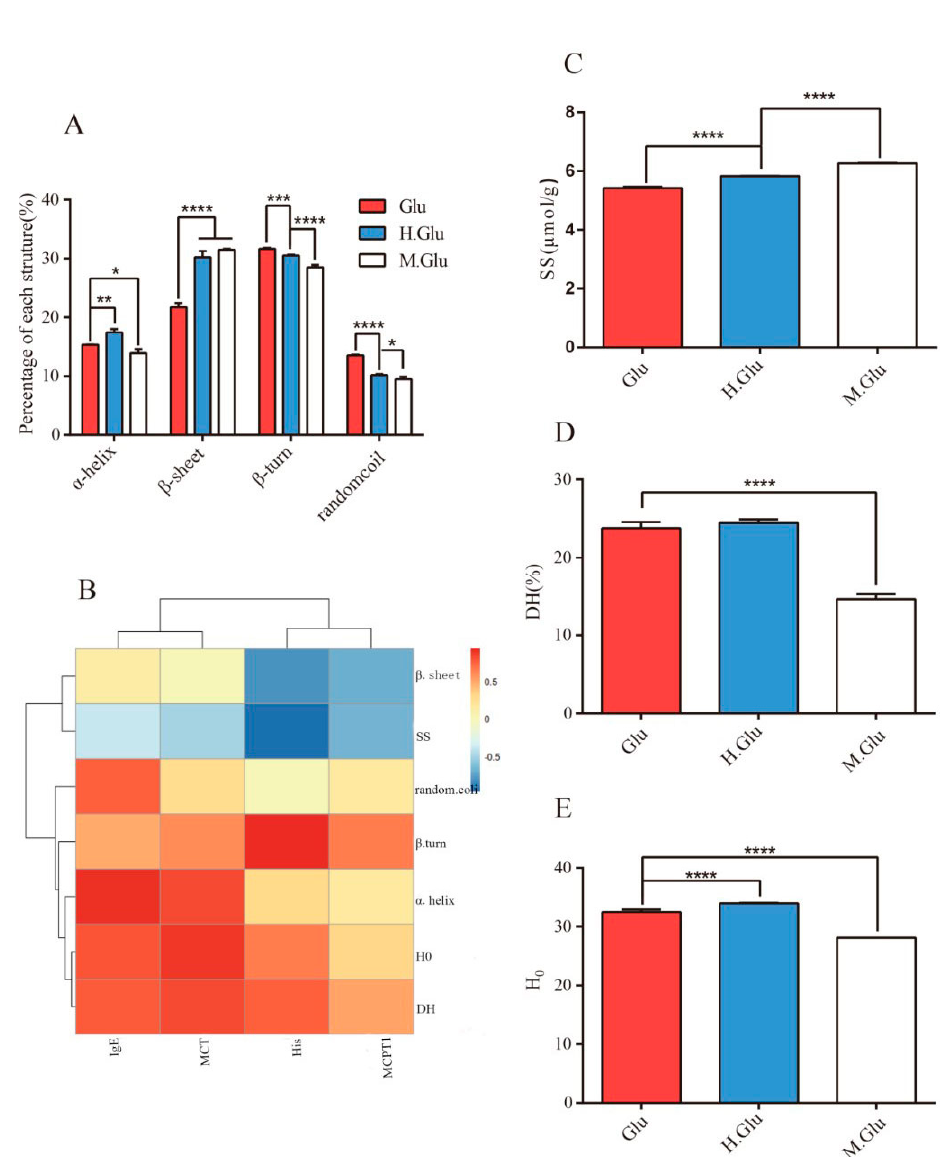
Figure 1. Methylglyoxal (MGO) changes the structure of glutenin. ( A ) Secondary structure changes. Significant differences among α -helix, β -sheet, β -turn, and random coil were indicated as * p < 0.05, ** p < 0.01, *** p < 0.001, **** p < 0.0001. ( B ) Correlation analysis between structural changes and sensitivity of glutenin. ( C ) Disulfide bond (SS) levels of glutenin and its corresponding reaction products. ( D ) Proteolytic hydrolysis (DH%) levels of glutenin and its corresponding reaction products. ( E ) H 0 levels of glutenin and its corresponding reaction products. Glu, H.Glu, and M.Glu represent native glutenin, heated glutenin, and MGO-glutenin, respectively.